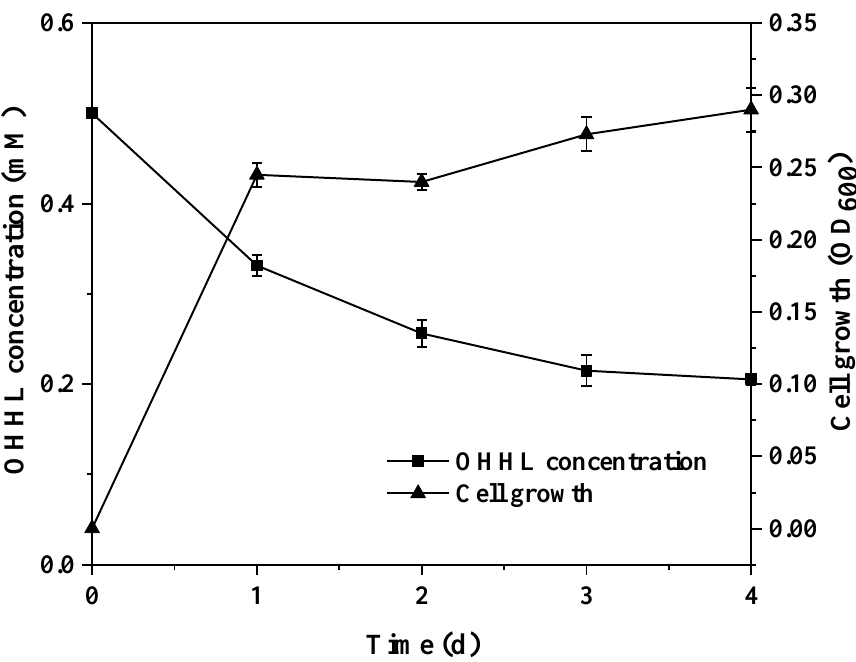
Figure 4. The relationship between N -(3-oxohexanoyl)-L-homoserine lactone (OHHL) degradation and growth of strain XN-10. Symbols: OHHL concentration; and cell growth. Values represent the mean of three repeats. Each experiment was conducted with three replicates. Bars indicate standard deviation of the mean.